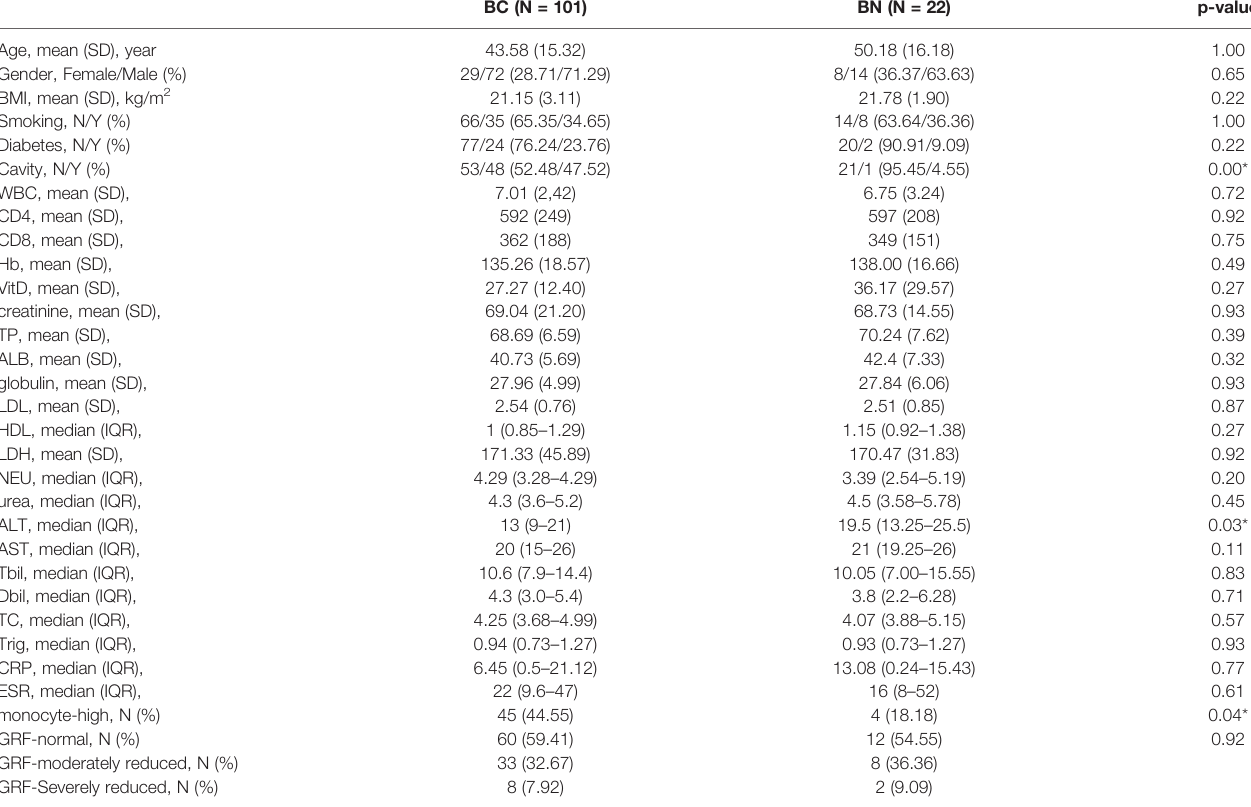
TABLE 1 | Demographics and clinical characteristics of study